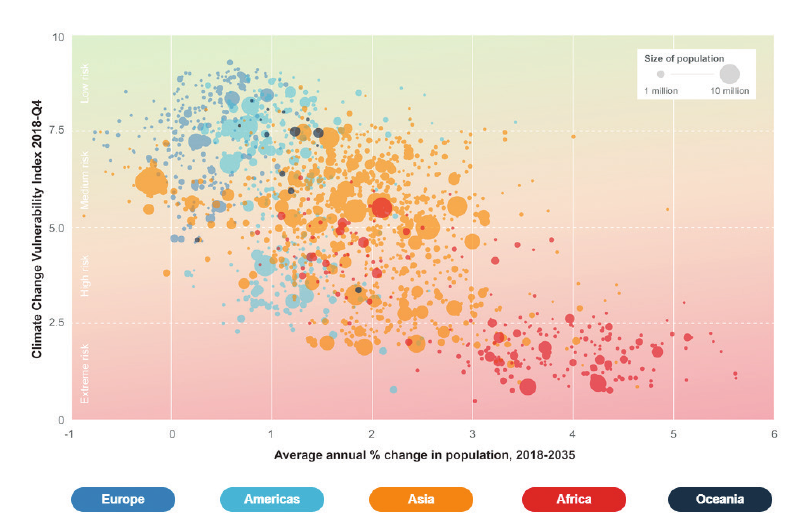
Figure 1. Climate change vulnerability index. Reproduced with